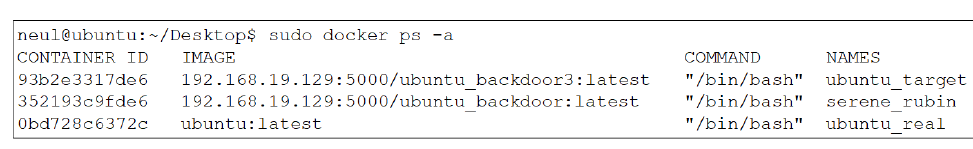
Figure 28. ubuntu_target docker container list (1).